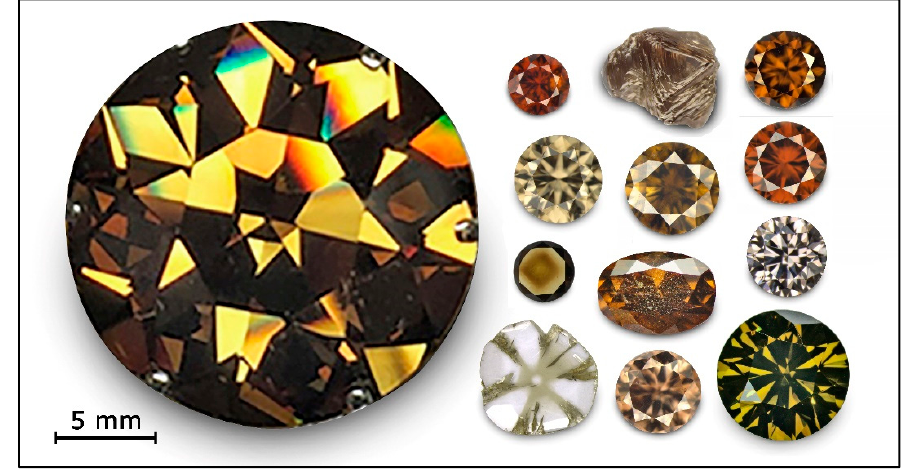
Figure 1. Part of the non-deformation-related (NDR) brown diamonds tested for this study, from left to right: First stone plus second column—hydrogen rich diamonds; second column—CO 2 and Pseudo—CO 2 diamonds; third column top two stones—treated brown diamonds; third column bottom two stones—synthetic brown diamonds.